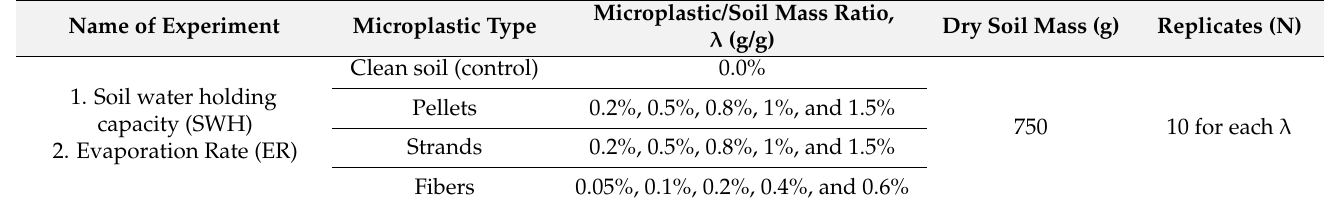
Table 1. Experimental design. Three different shapes (types) of MP—polyacrylic (fibers), polymethyl methacrylate (strands), and acrylonitrile butadiene styrene (pellets), with six levels of λ (g/g), were studied for each